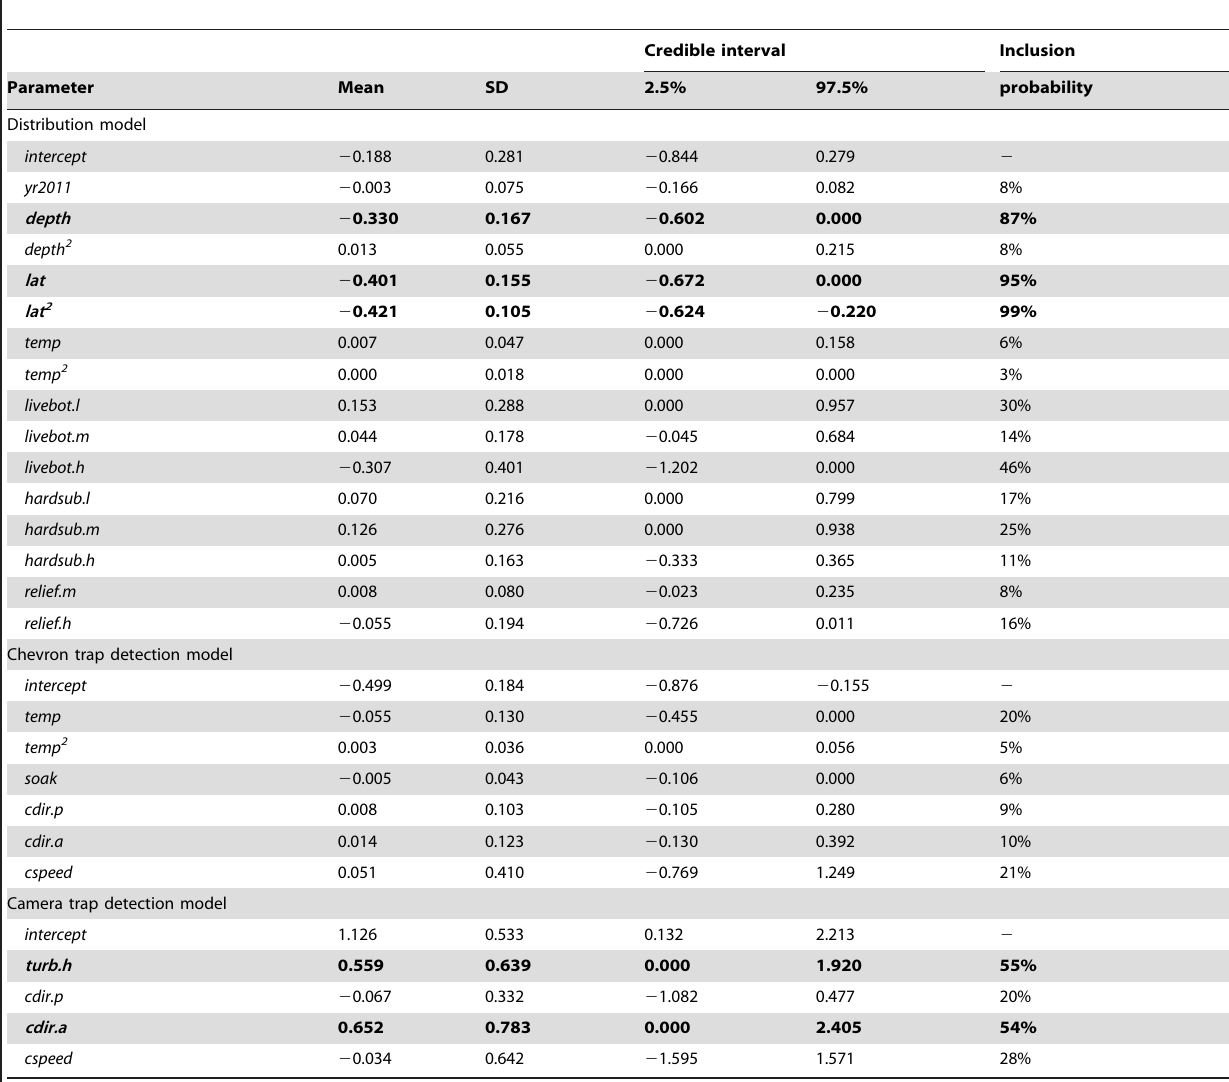
Table 3. Posterior probability summaries of parameters evaluated in the red snapper Lutjanus campechanus basic occupancy model using pooled camera trap data and without a site-specific random effect on camera trap detection probability (Bin( y ) Bin( p chevron ) Bin( p camera